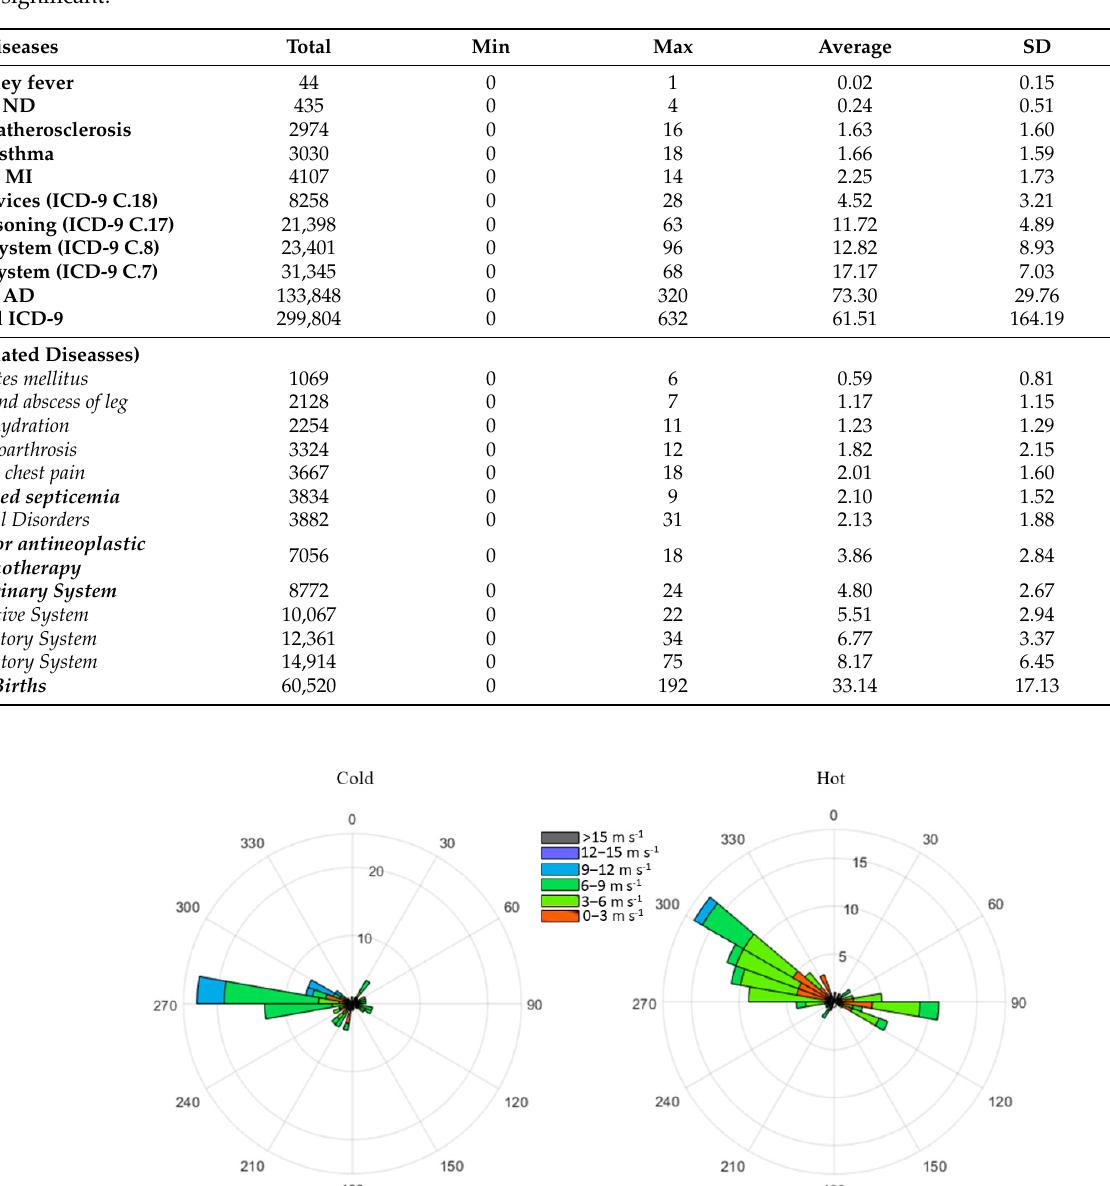
Table 1. Descriptive analysis of disease categories and associated hospitalizations. El Paso County, TX, 2010–2014. Categories in bold were found by the analyses to have some significant association with specified increases in PM 10 concentration and/or wind speed at some lag between 0 and 7 days. Categories in italics are part of AD; those in bold were individually significant.